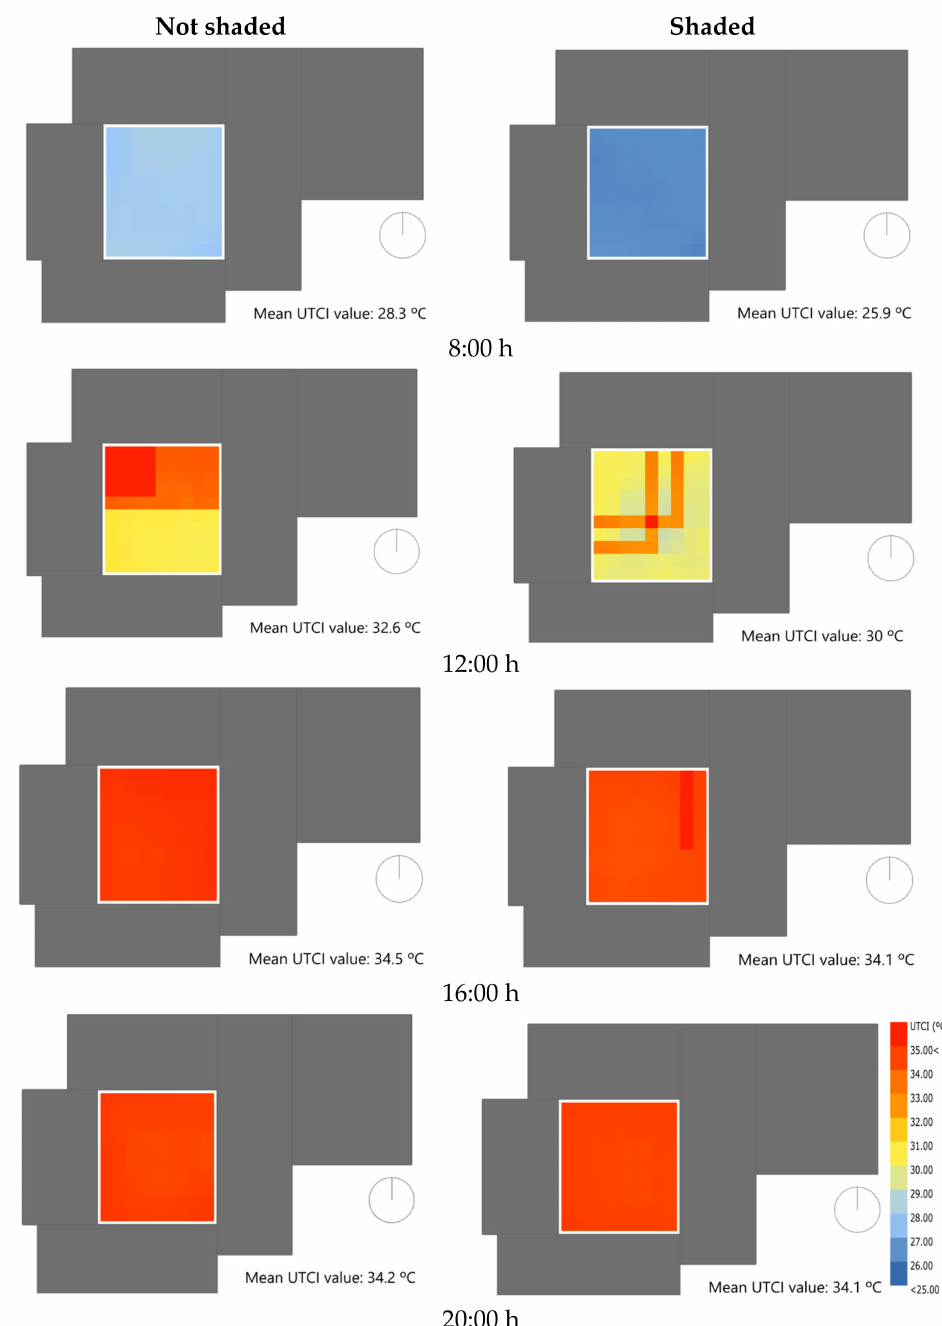
Figure 9. UTCI values at a 1.5 m height in the courtyard at different hours based on the Ladybug simulation workflow. Left : without shading. Right :